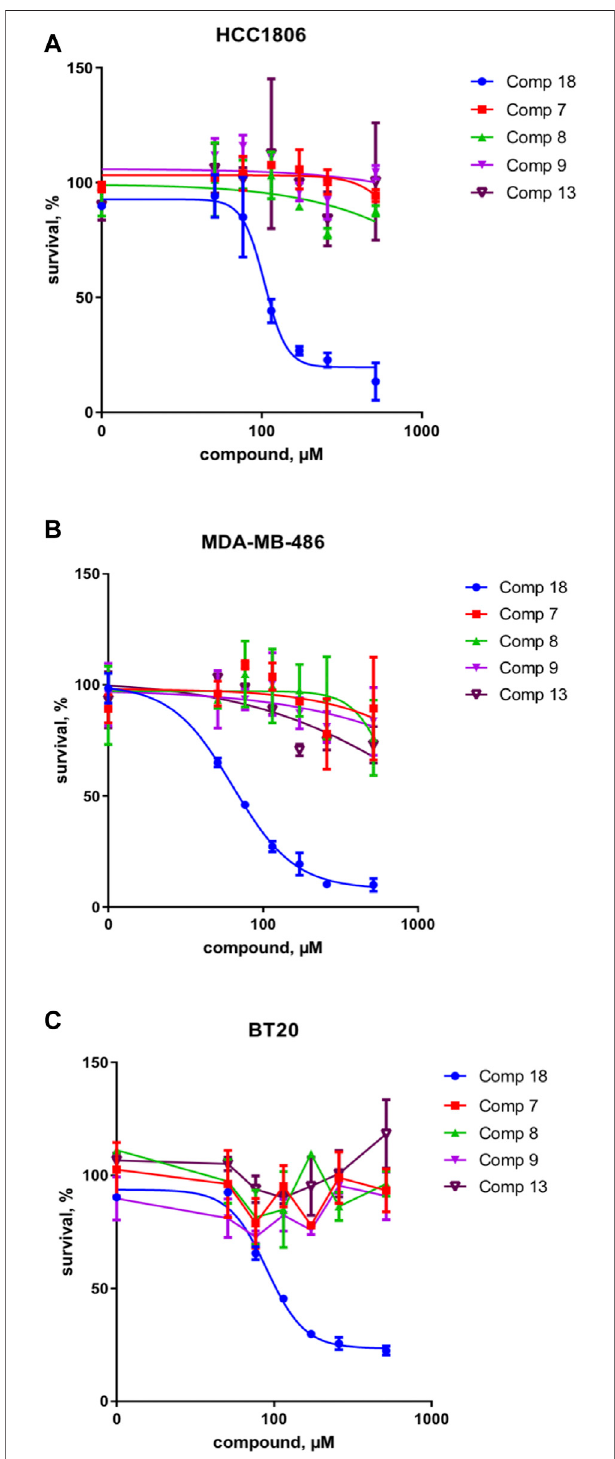
FIGURE 7 | Survival of three different TNBC cancer cell lines in % of controlforcompounds18and7,8,9,and 13in (A) HCC 1806, (B) MDA-MB- 486, and (C) BT20 cell lines. Compound 18 inhibits the proliferation of three TNBC cell lines and thus shows a broad effect on the TNBC cell types.